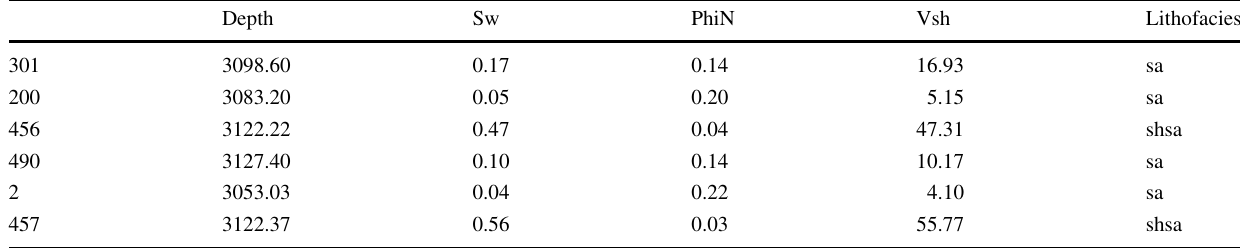
Table 2 Head of the sampled training subset data for the well under study